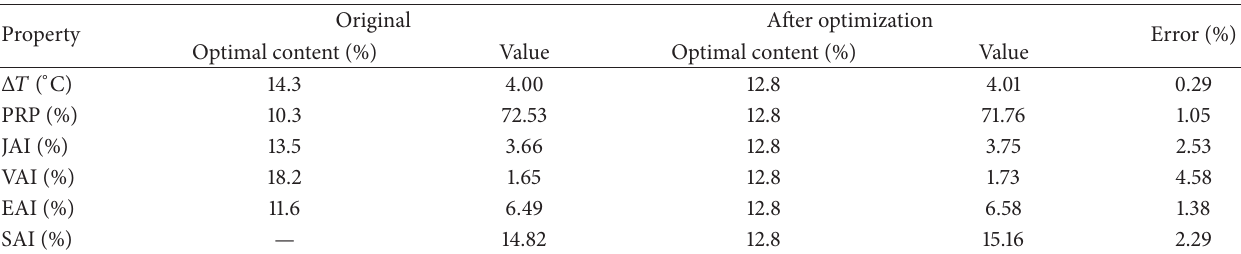
Table 7: Results of unified optimal content of